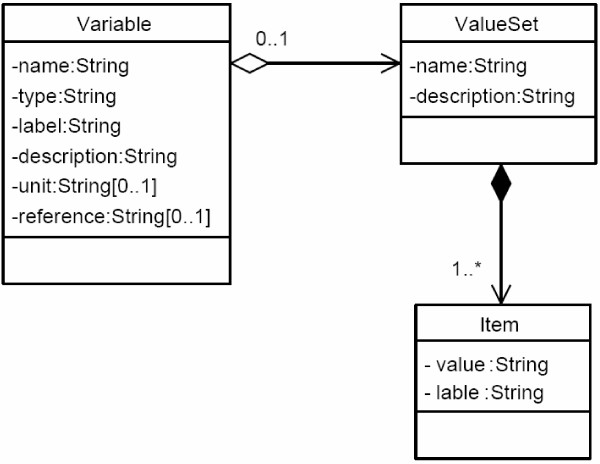
CDS UML Class Diagram.